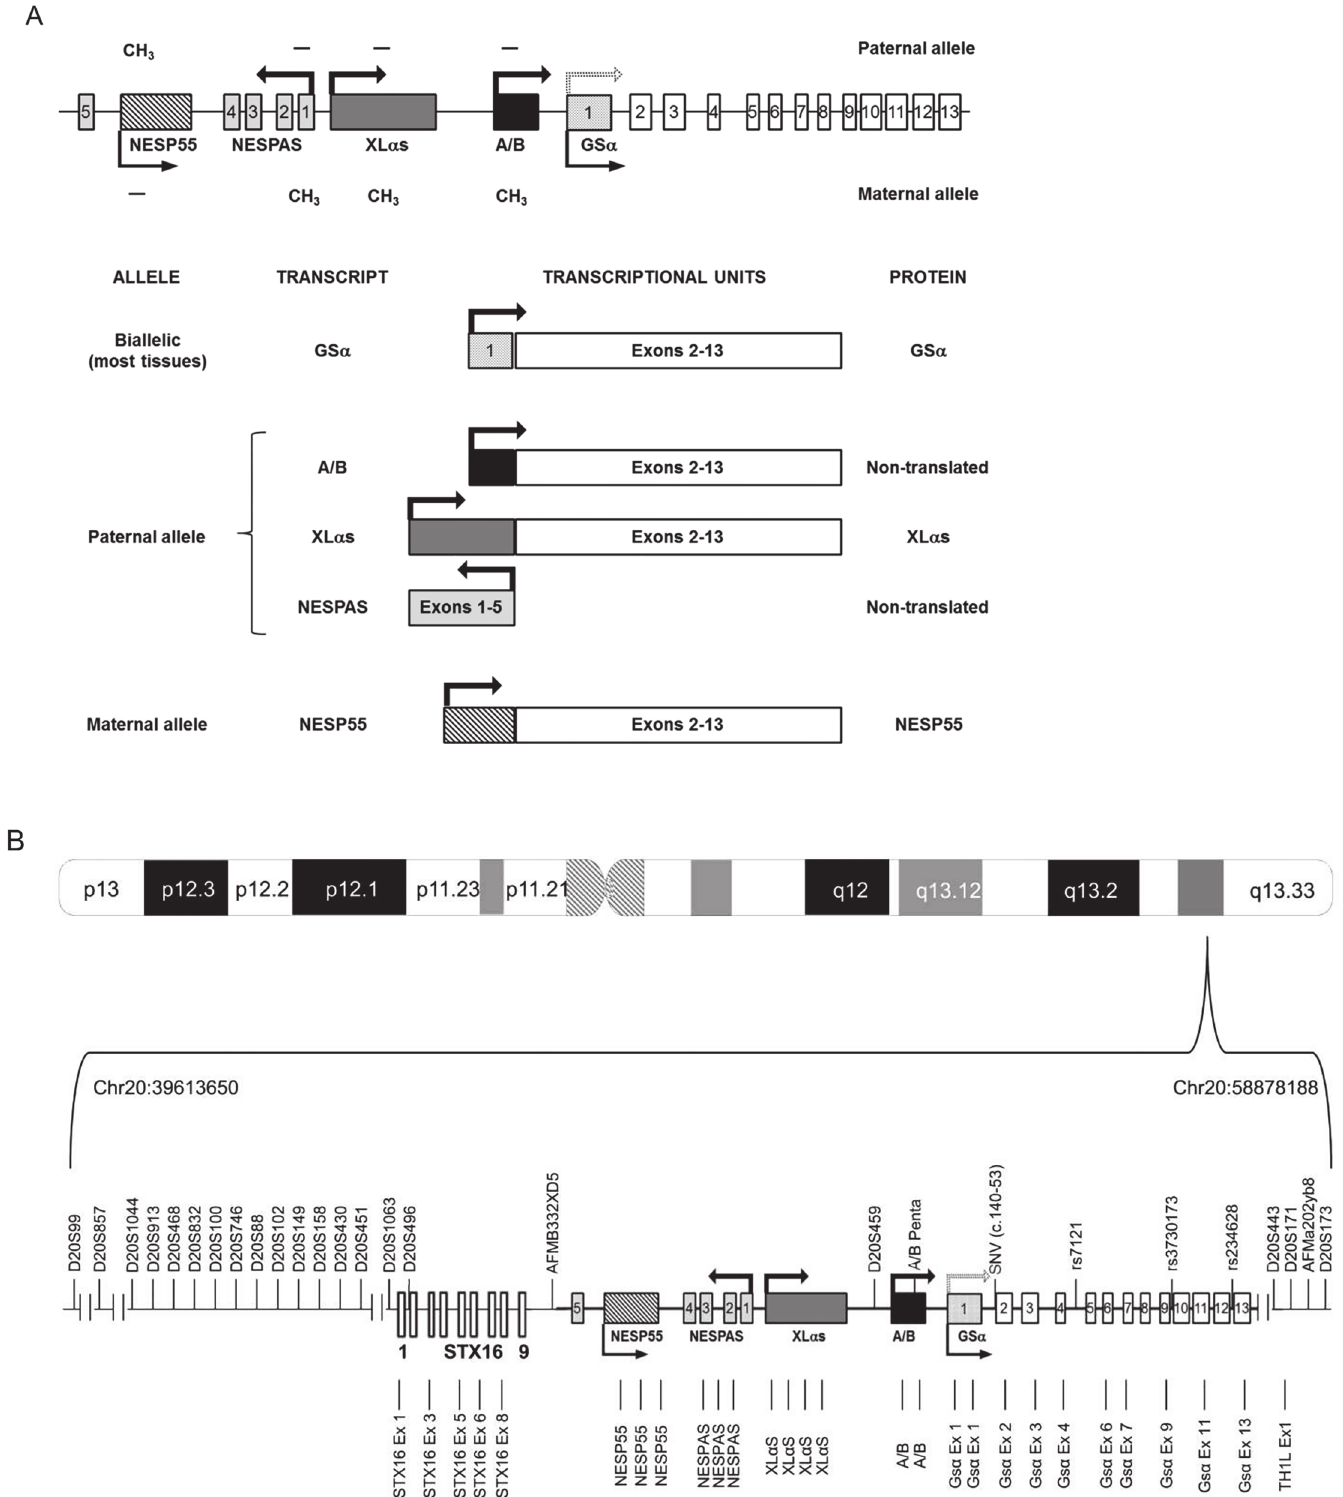
Fig 1. Graphic representation of the GNAS complex locus. (A) Alternative exons and transcripts in the region. Each first alternative exon is depicted in a different format (the scratched rectangle corresponds to NESP55, the dark grey rectangle to XL α s, the black rectangle to exon A/B and the dotted rectangle to GS α exon 1). NESPAS exons 1 – 5 are shown as soft grey rectangles. White rectangles represent common exons 2 – 13 and the continuous line represents